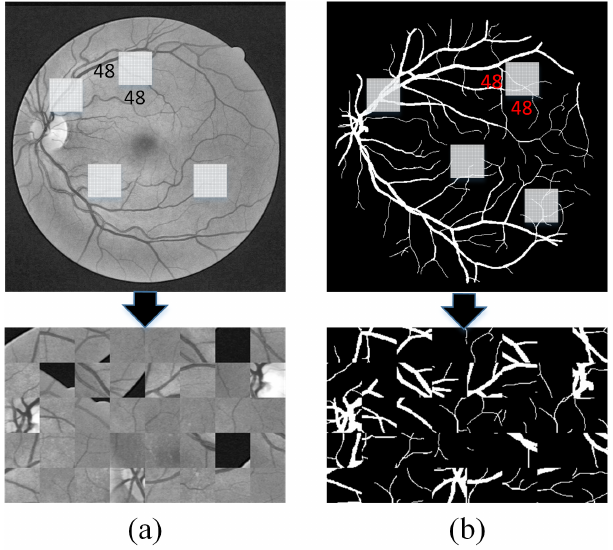
Figure 4. Samples of random segmentation: ( a ) randomly extract 48 × 48 patch image blocks from the preprocessed image and ( b ) the corresponding label from the gold standard